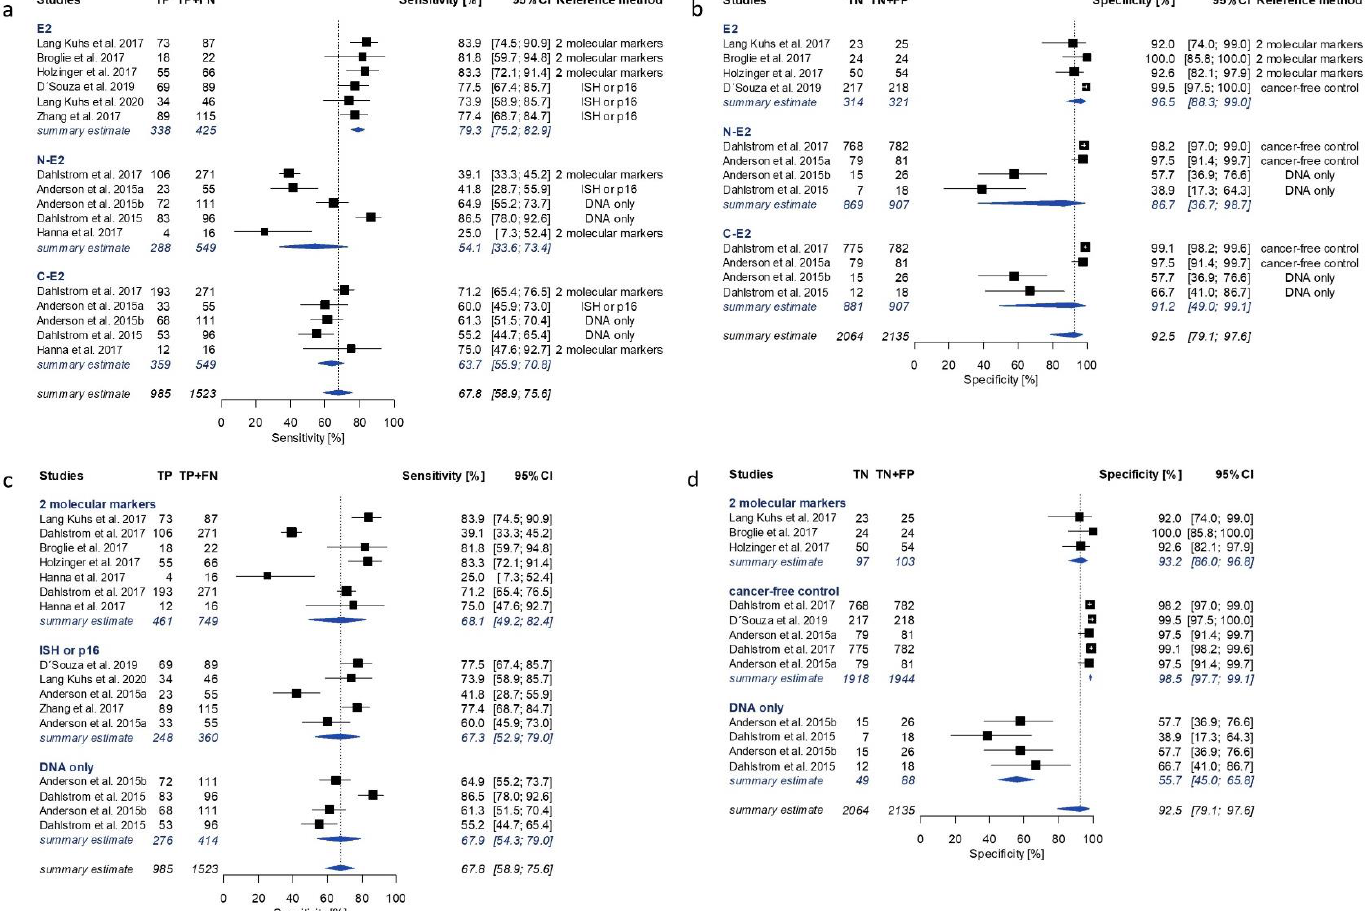
Figure 5. Forest plots of study-specific sensitivity and specificity estimates and summary estimates of HPV16 E2 serology in comparison with molecular HPV tumor status. Pooled estimates were calculated by univariate analysis of log-transformed proportions using a random effects model. Sensitivity of E2 with subgroup summary estimates (I 2 = 90.6% (86.3–93.5%)) was stratified by ( a ) E2 antigens and ( c ) reference method. Specificity of E2 with subgroup summary estimates (I 2 = 94.2% (91.6–96.0%)) was stratified by ( b ) protein variant and ( d ) reference method. TP: true positive; FN: false negative; TN: true negative; FP: false positive; CI: confidence intervals; ISH: in situ hybridization; p16: p16 immunohistochemistry; DNA only: HPV DNA PCR.